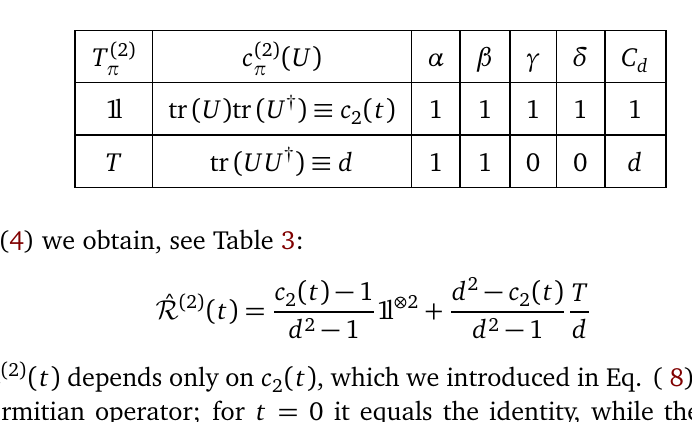
Table 3: Calculation of the spectral functions c ( 2 ) responding powers α , β , γ , δ and the constant C ( t ) c 2